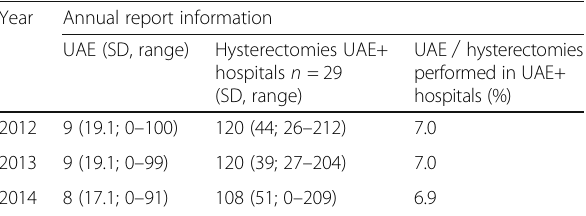
Table 1 Mean number of UAE ’ s, hysterectomies per UAE+ hospital ( n = 29) and UAE/hysterectomy ratio